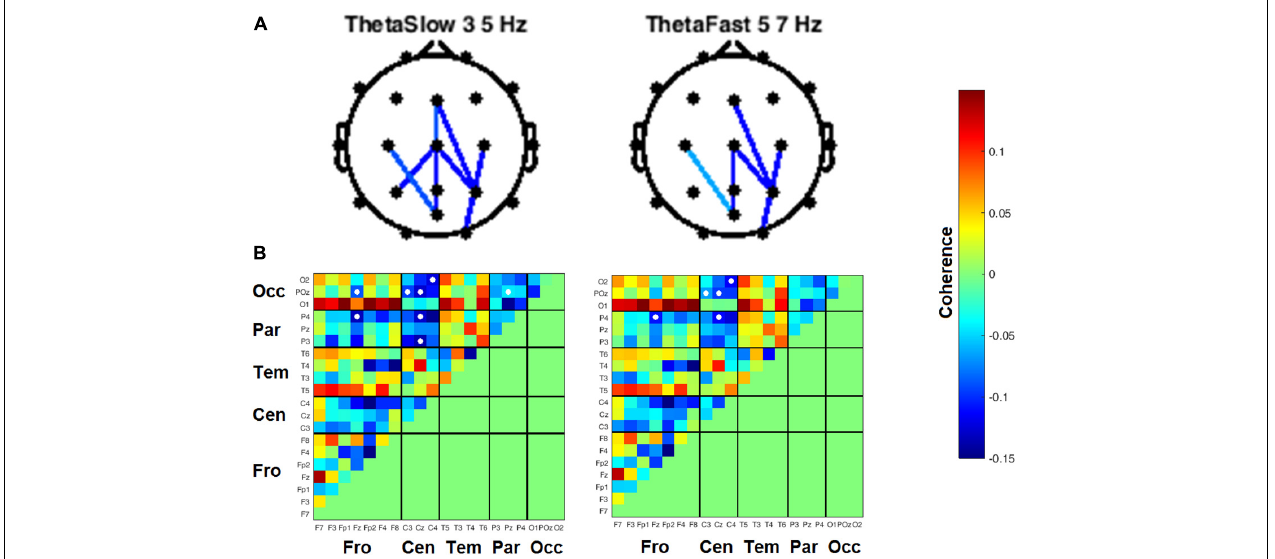
FIGURE 8 | Inter-channel coherence differences between visits, resting state eyes open. Reduction of coherence between anterior and posterior regions during THC visit. (A) Topographic maps of channel pairs by frequency band significant at α = 0.05. (B) Accompanying heat maps of coherence by frequency band for all channel pairs. Significant pairs marked with white circles. Channels grouped by region for easier comparisons. Occ, occipital channels; Par, parietal channels; Tem, temporal channels; Cen, central channels; Fro, frontal